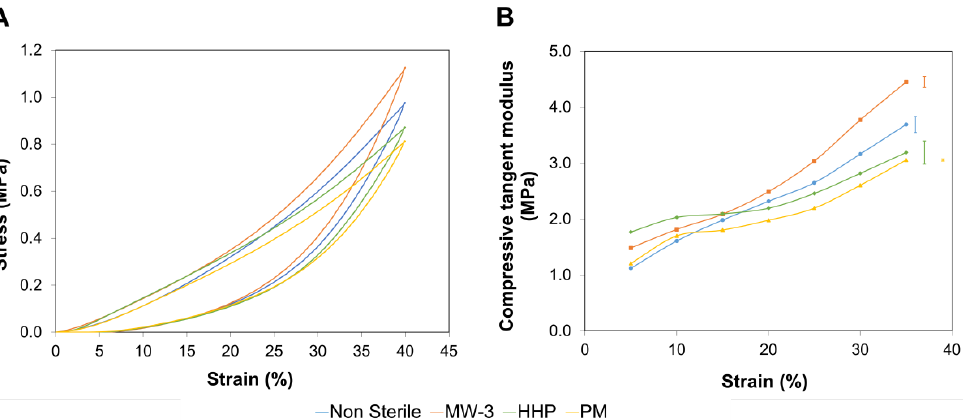
Figure 5. Typical compressive stress-strain curves ( A ) and compressive tangent modulus ( B ) for non-sterile and sterile PVA/PBO hydrogels. The error bars represent the mean ± standard deviations ( n = 3).